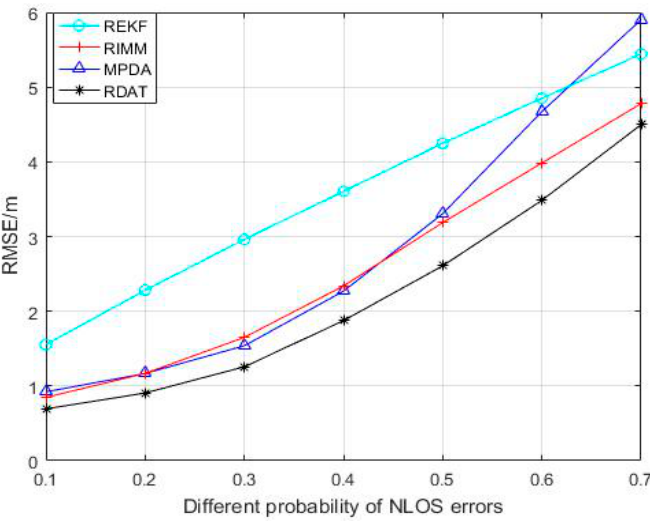
Figure 4. Performance comparison between RIMM, REKF, MPDA, and RDAT under different mean values of NLOS error µ NLOS , where P NLOS = 0.5, and N